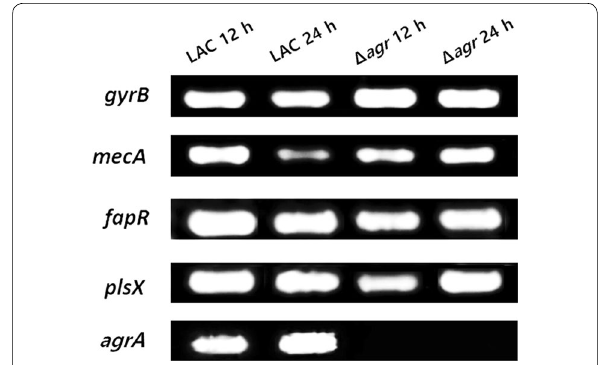
Fig. 6 Semi‑quantitative RT‑PCR of mecA and the fatty acid synthetic